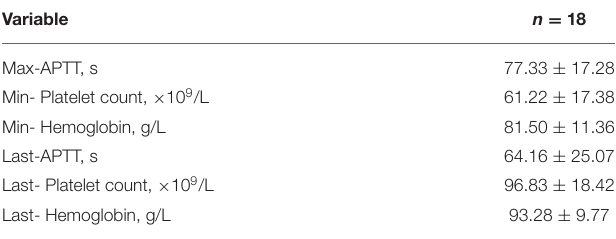
TABLE 7 | Analysis of hemorrhage-related indicators in the hemorrhage